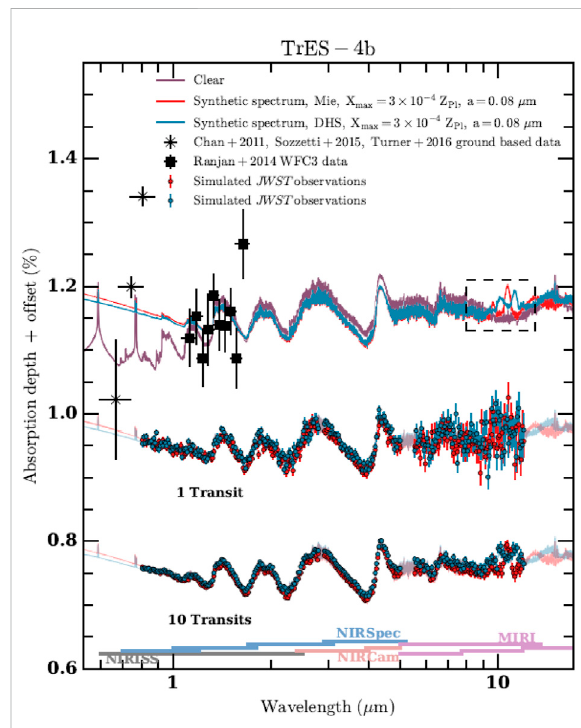
FIGURE 4 SimulatedJWST transitobservationsfor thehotJupiterTrES- 4b. Shown in this fi gure are 2 models with different silicate cloud particles and one model without clouds. The dashed box at 10 μ m highlights the silicates cloud features due to Mg 2 SiO 4 resonances for different dust grain models. Also shown in the fi gure are current observations with HST and ground based instruments (see (Molliere et al., 2017) for details and references). Reproduced with permission from (Molliere et al., 2017) ©